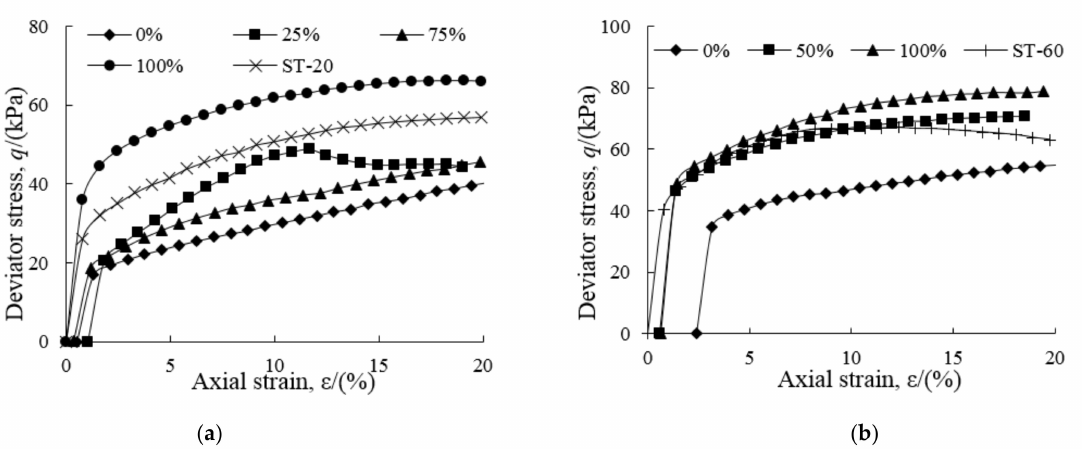
Figure 8. Relationship after cyclic loading between axial deviator stress and axial strain of the soft soil with different degrees of reconsolidation ( n = 1000, CSR = 0.25): ( a ) p (cid:48) 0 = 20 kPa; ( b ) p (cid:48) 0 = 60 kPa.